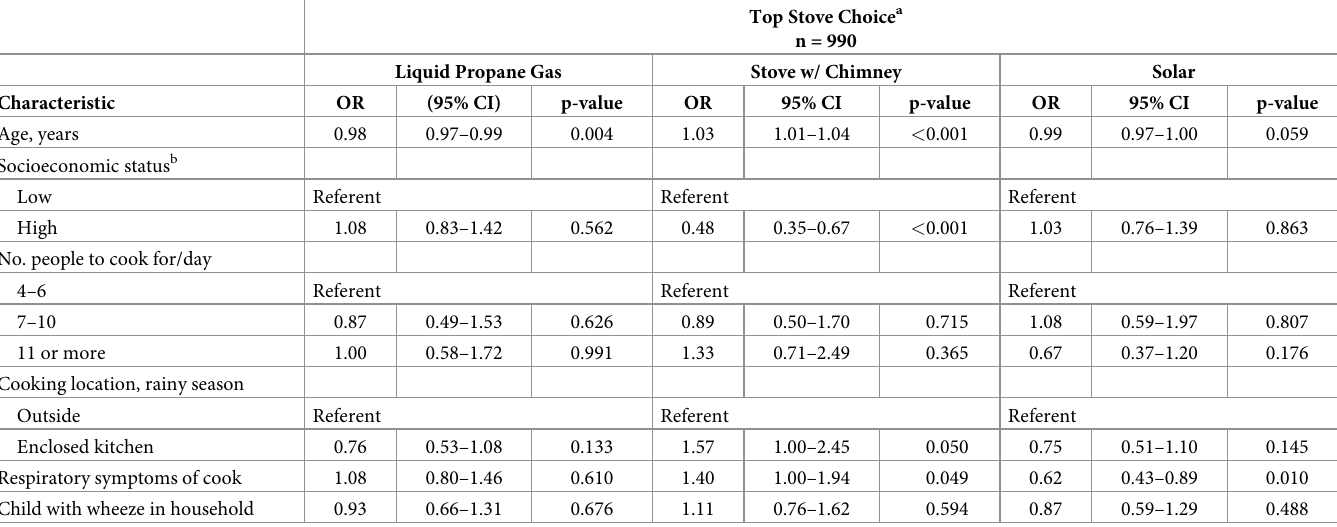
Table 2. Associations (odds ratios) between respondent characteristics and first choice of most desired stove